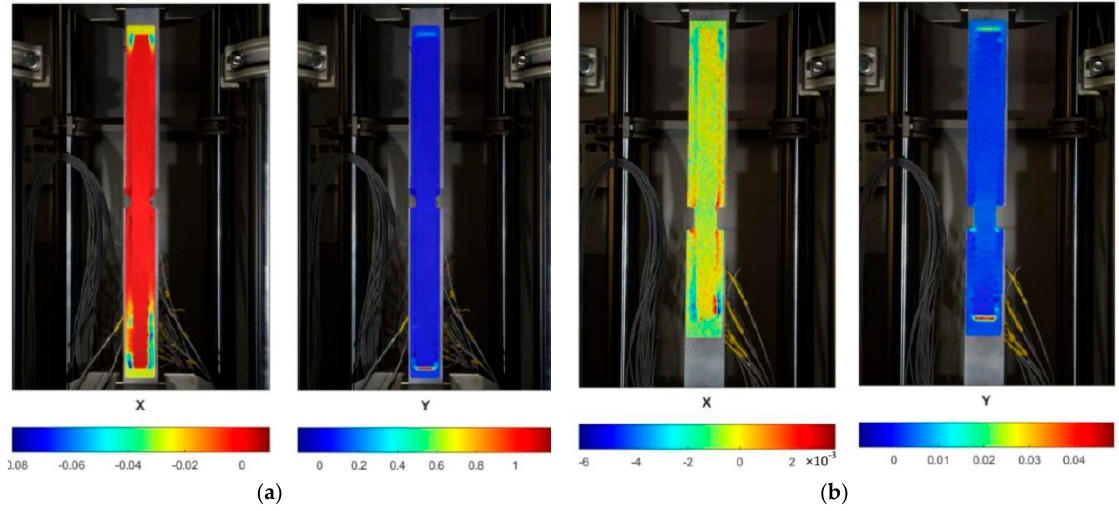
Figure 11. Strain distribution maps at final failure (horizontal direction—X, vertical direction—Y): ( a ) Specimen S/DL/MA/RS-400-4/P2—438kN, ( b ) specimen S/DL/MA/RS-200-4/P2—330kN.